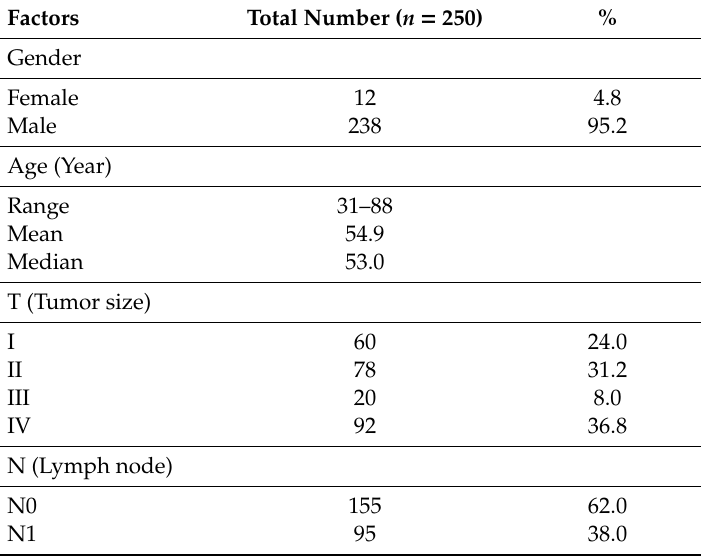
Table 1. Demographic and characteristics among oral oral squamous cell carcinoma (OSCC)